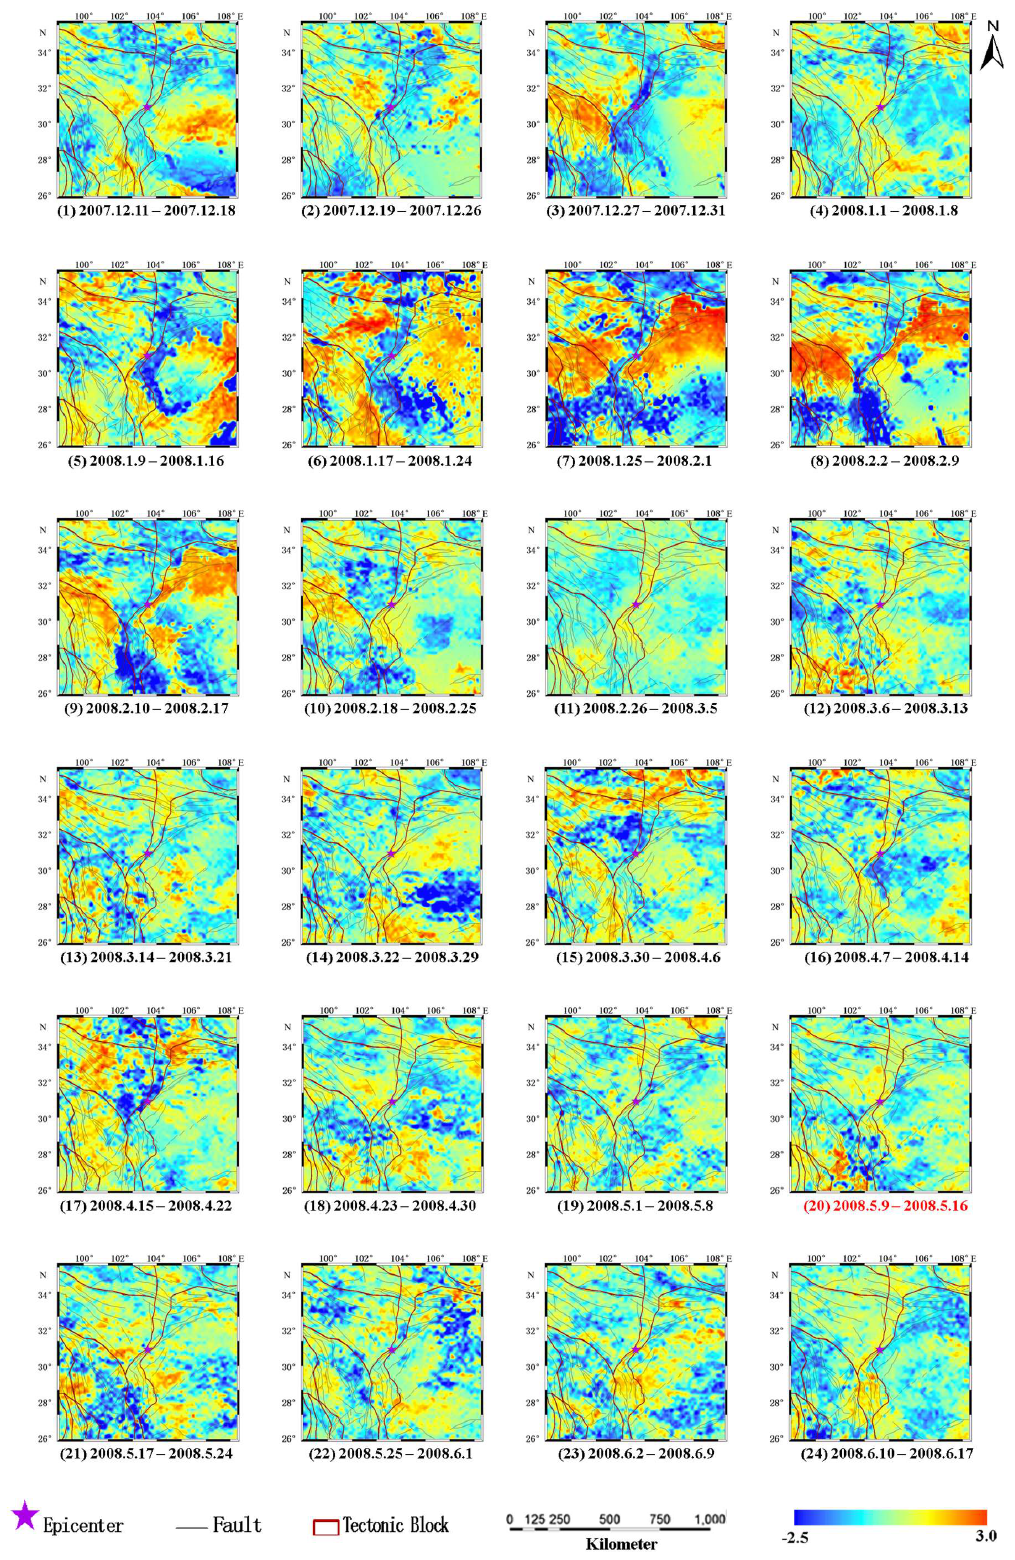
Figure 13. Spatio-temporal evolution of K tec extracted by the TTIA method in the Longmenshan fault region around the period Ms 8.0 Wenchuan earthquake breaking out in 2008. The date in red writing indicates the period that the earthquake